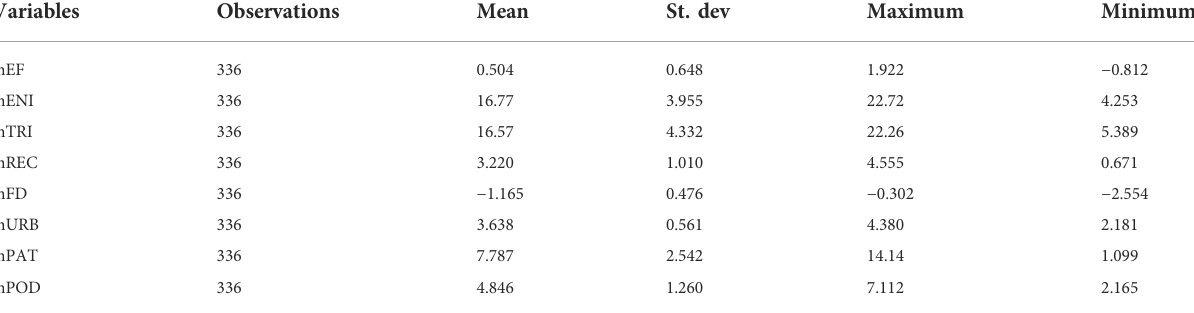
TABLE 2 Descriptive